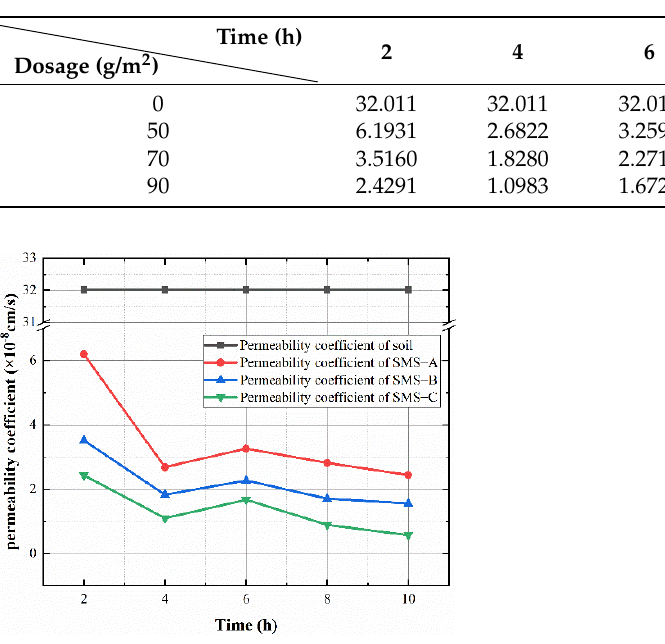
Table 4. Summary table of permeability coefficients of soils under different hydrophobic treatments ( × 10 − 8 cm/s).